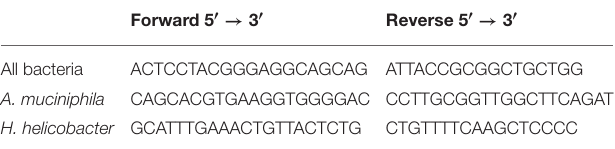
TABLE 4 | Primers of 16S rDNA qPCR